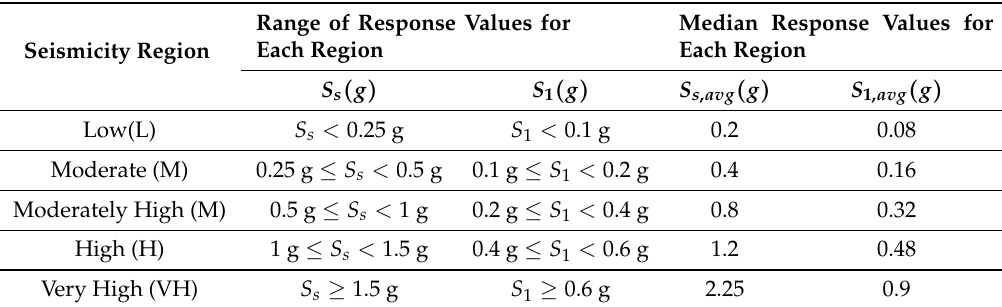
Table 2. Range and Median Maximum Considered Earthquake (MCE) Spectral Response Acceleration Values in Each Seismic Region [16].